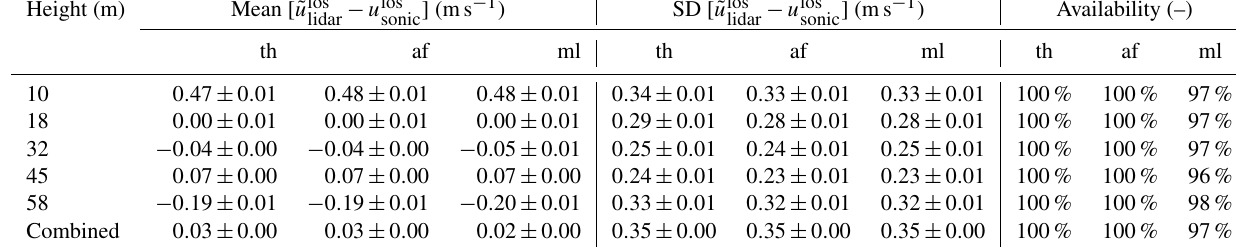
Table 3. Performance of lidar retrieval techniques versus sonic anemometer for inflow cases without solid interference. The abbreviations are threshold (th), advanced filter (af), and machine learning (ml). SD refers to standard deviation. Height (m)